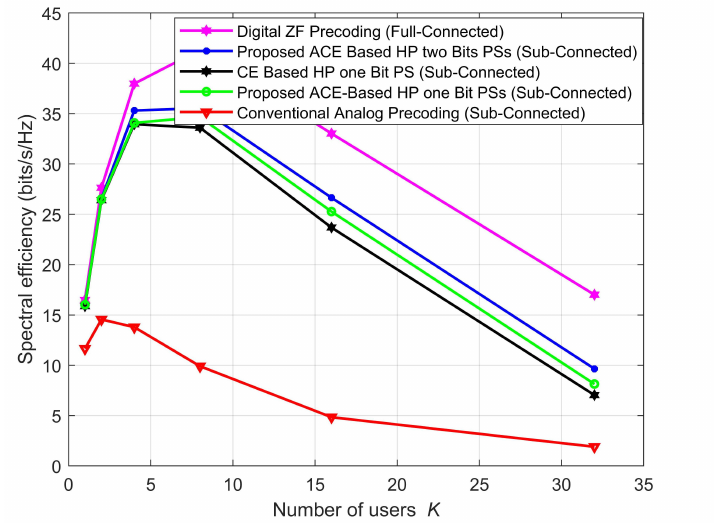
Figure 6. Spectral efficiency of ACE-based method with sub-connected PSs (when C = A = 10 and SNR = 30).